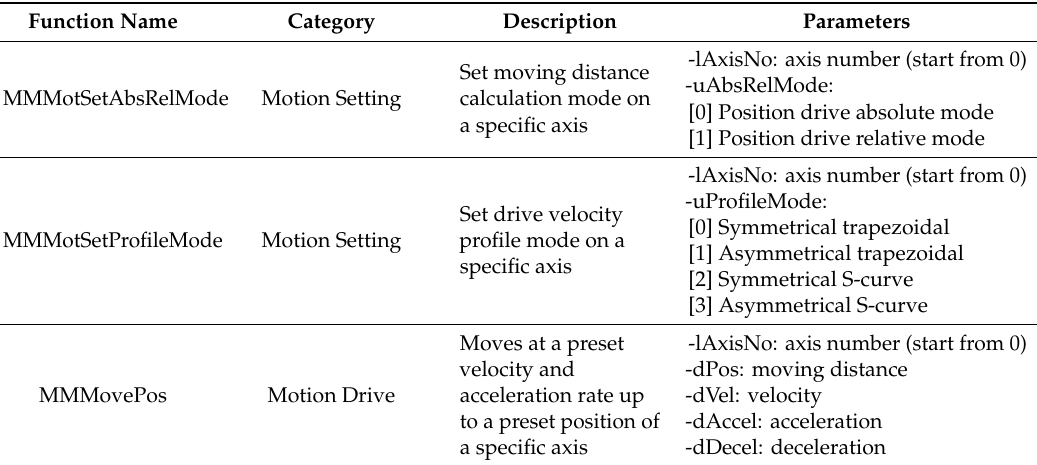
Figure 14. General architecture of software-based development. Table 5. Examples of API